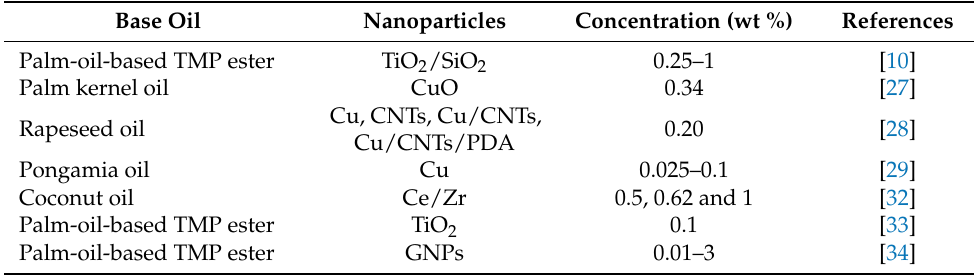
Table 1. Literature review of vegetable-oil-based nanolubricants.